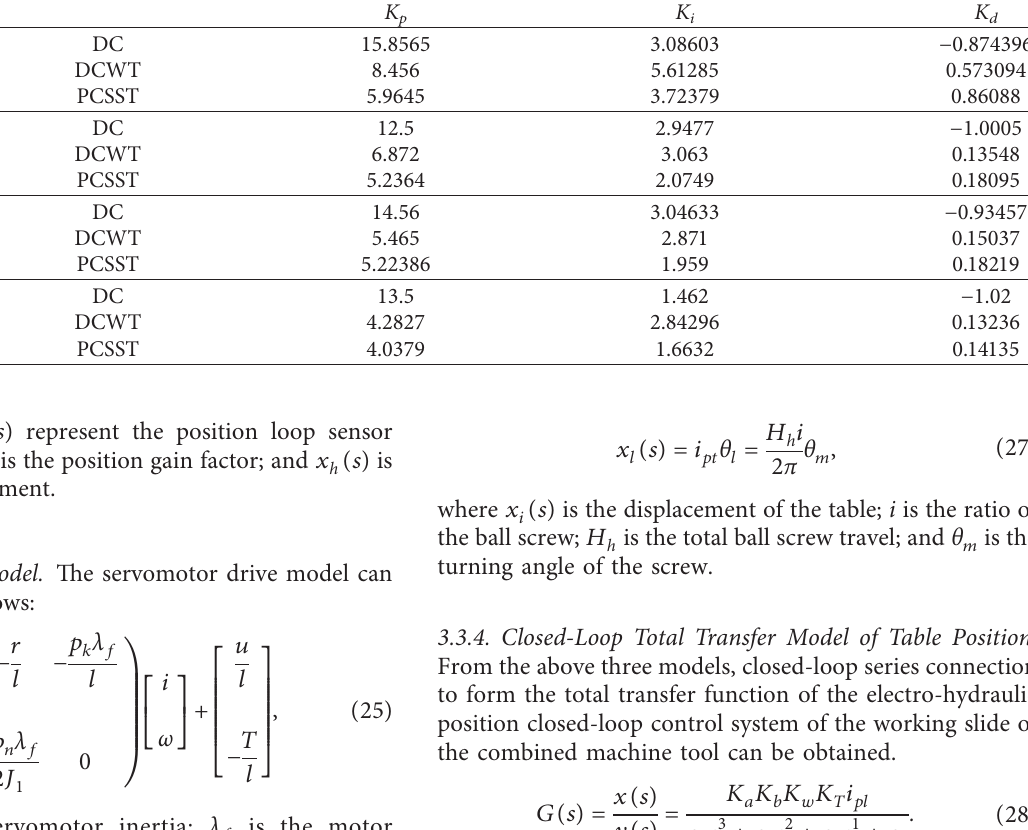
Table 4: The optimal parameters of the PID controllers of the three models.